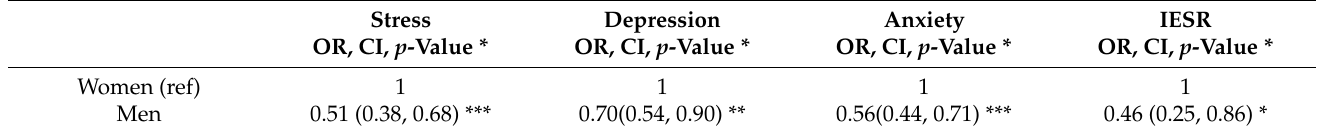
Table 4. The extent to which men and women experience stress, depression, anxiety, and IESR is significantly different (unadjusted